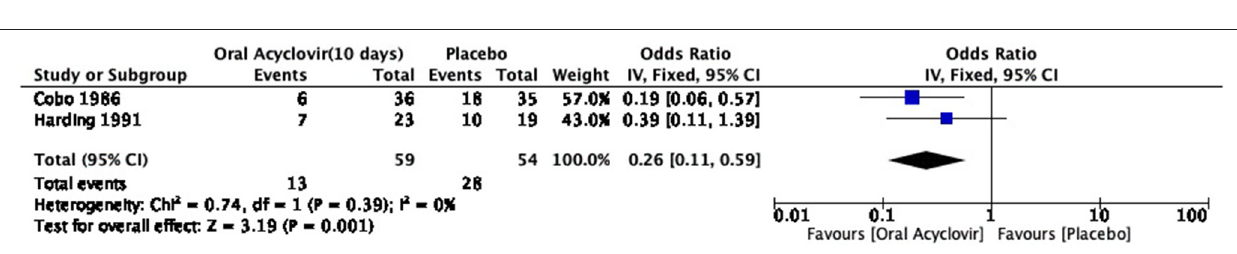
FIGURE 4 | Forest plot comparing treatment failure in herpes simplex virus anterior uveitis patients treated with oral acyclovir vs. placebo.